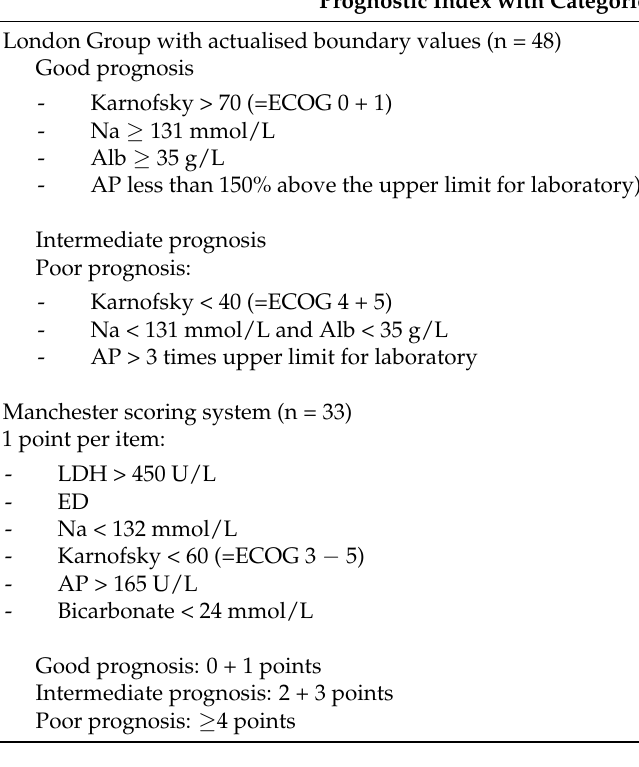
Table 4. Cont . Prognostic Index with